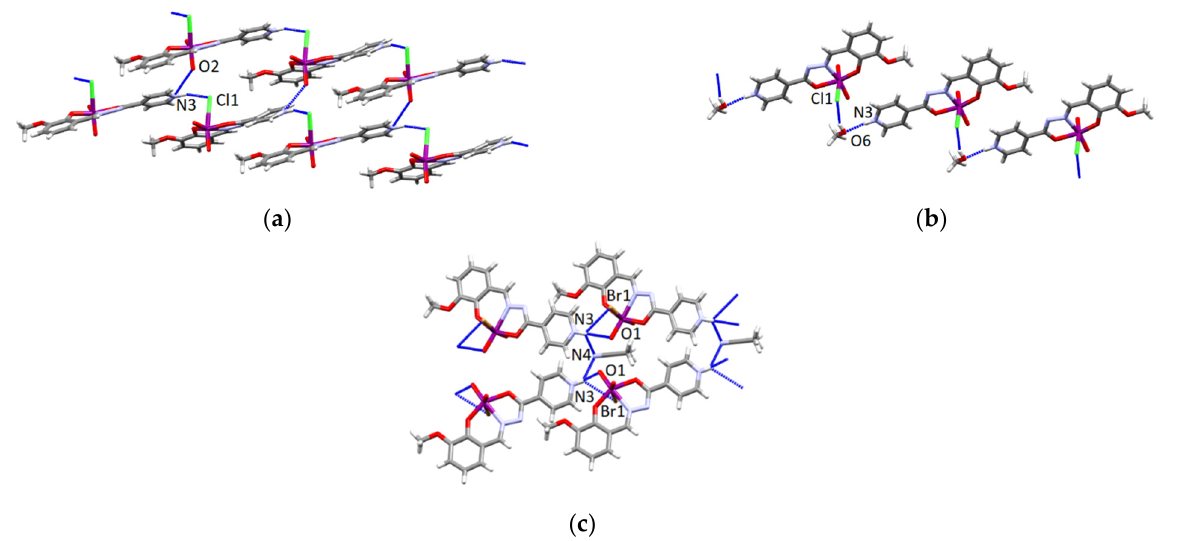
Figure 6. ( a ) 2D network in 2Cl formed by N3 − H3 ⋯ Cl1 and N3 − H3 ⋯ O2 hydrogen bonds. ( b ) Infinite 1D chain formed by N3 − H3 ⋯ O6 and O6 − H6A ⋯ Cl1 hydrogen bonds in 2Cl ·MeOH. ( c ) 2D network in 2Br ·0.5MeCN formed by N3 − H3 ⋯ O1, N3 − H3 ⋯ Br1 and N3 − H3 ⋯ N4 hydrogen bonds. Hydrogen bonds are shown by blue dotted lines.